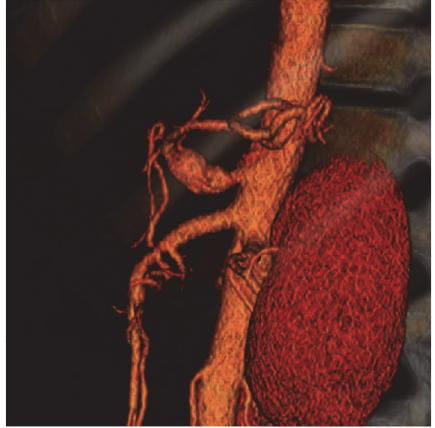
Figure 1: CT angiogram showing length of dissection of the celiac artery to the splenic vein.